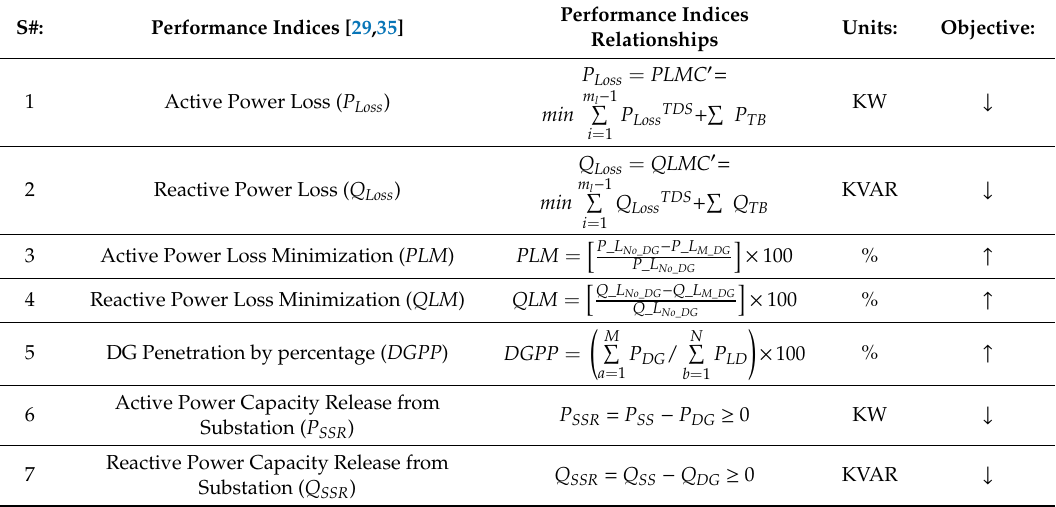
Table 1. Technical-based performance indices (designated in this paper as TPIs or TPs).